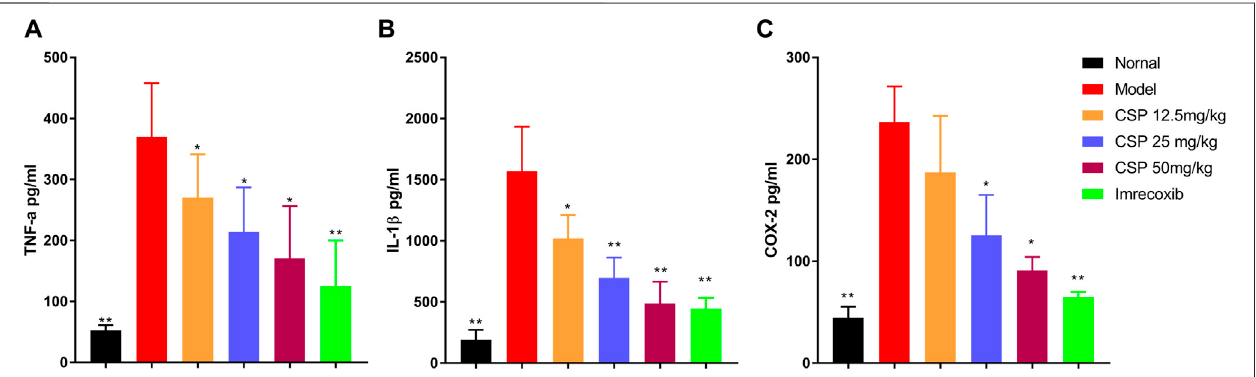
Pathological changes of articular membrane cartilage